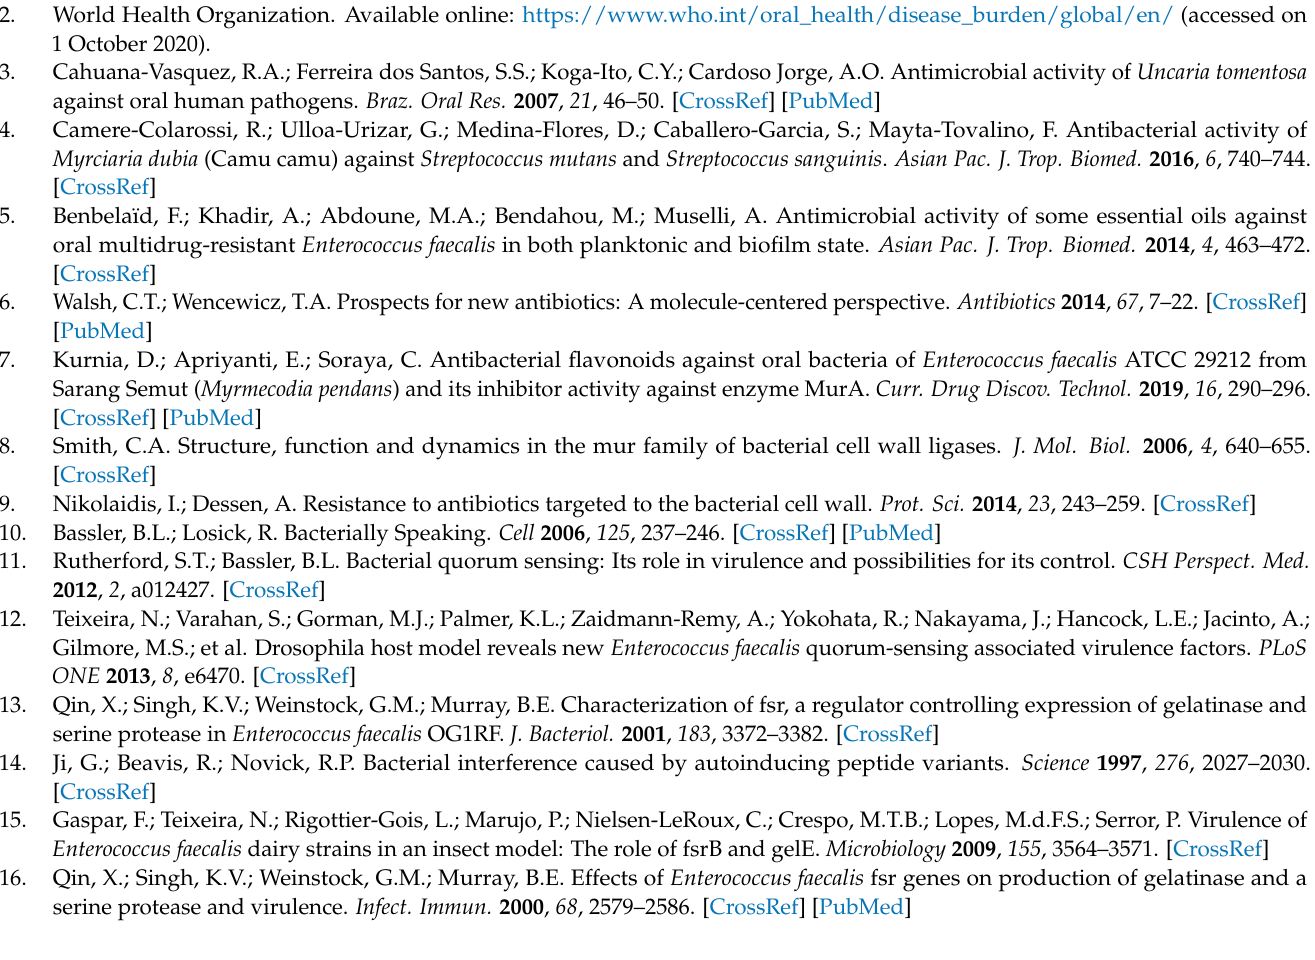
Figure S2: Chromatogram of the first separation, Figure S3: Chromatogram of the second sepa- ration, Figure S4: Chromatogram of the third